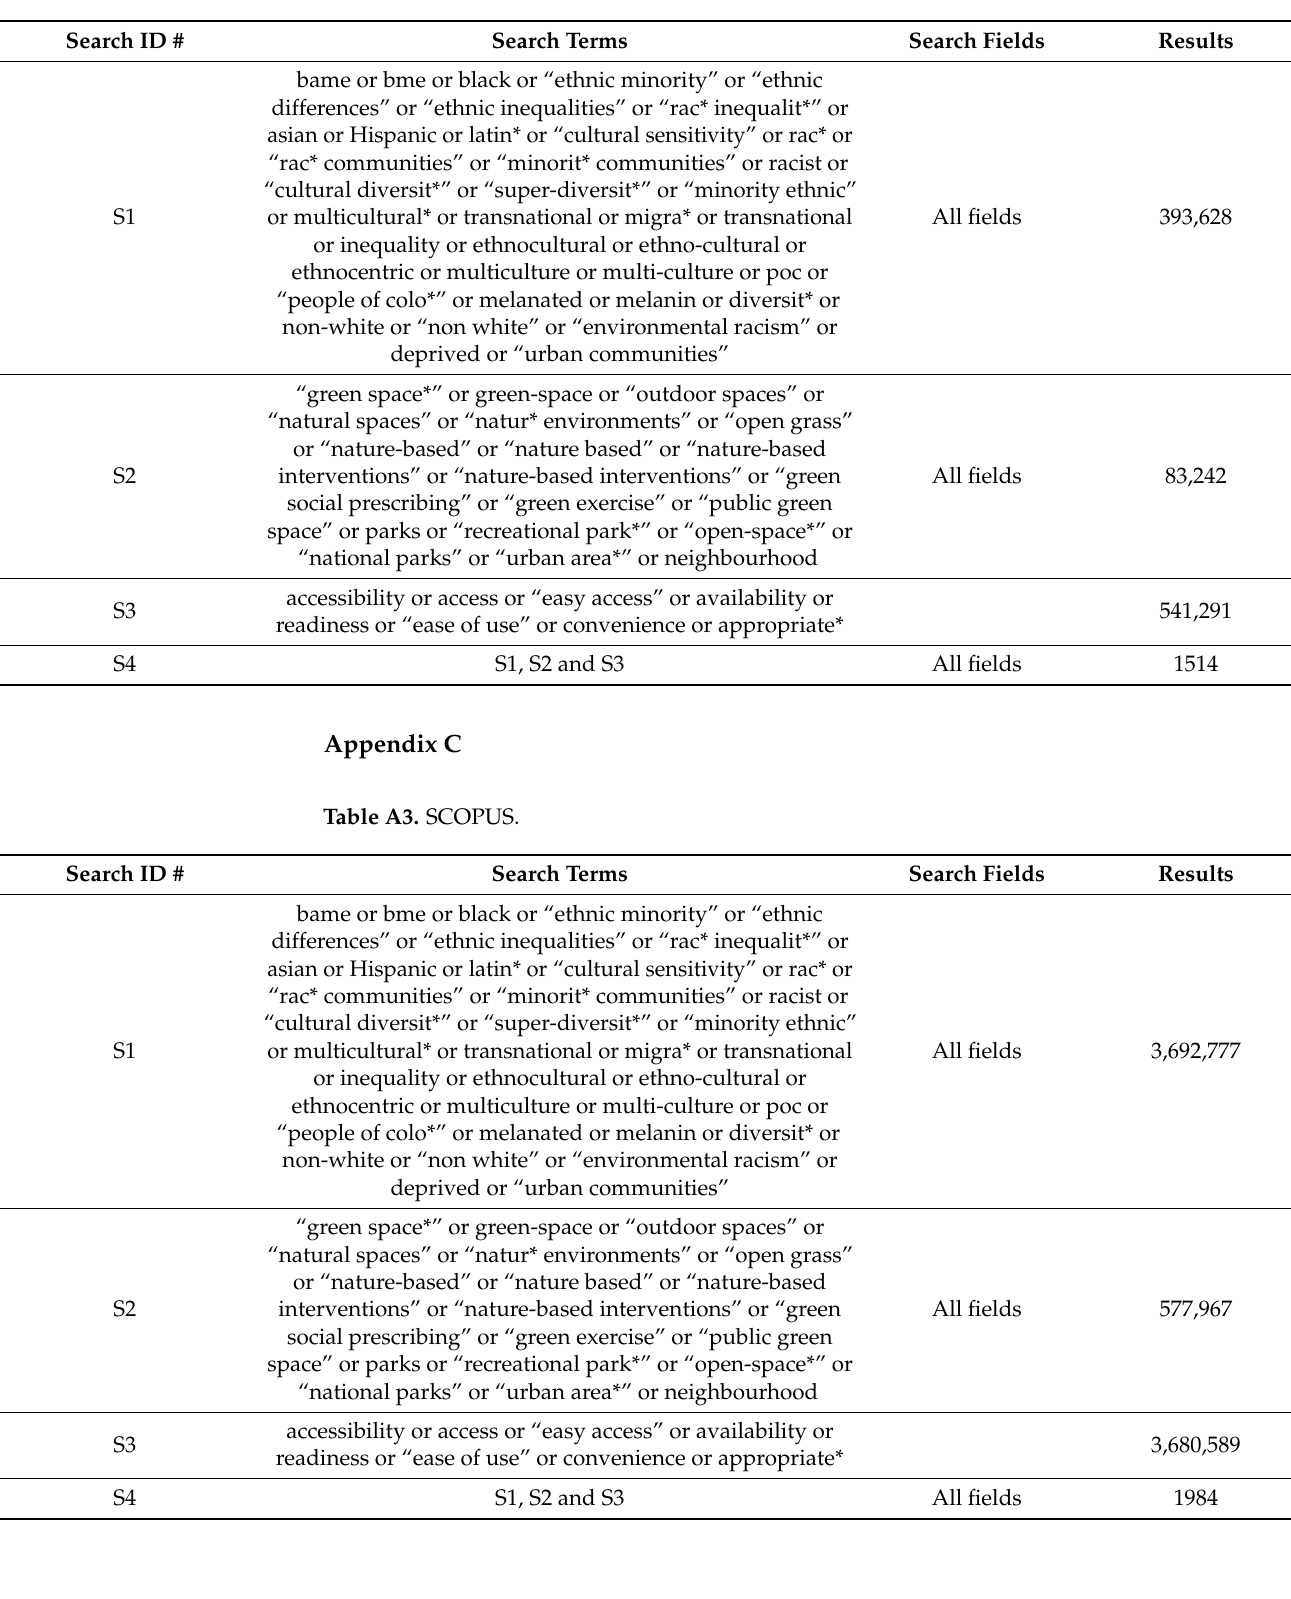
Table A2. Cumulated Index to Nursing and Allied Health Literature